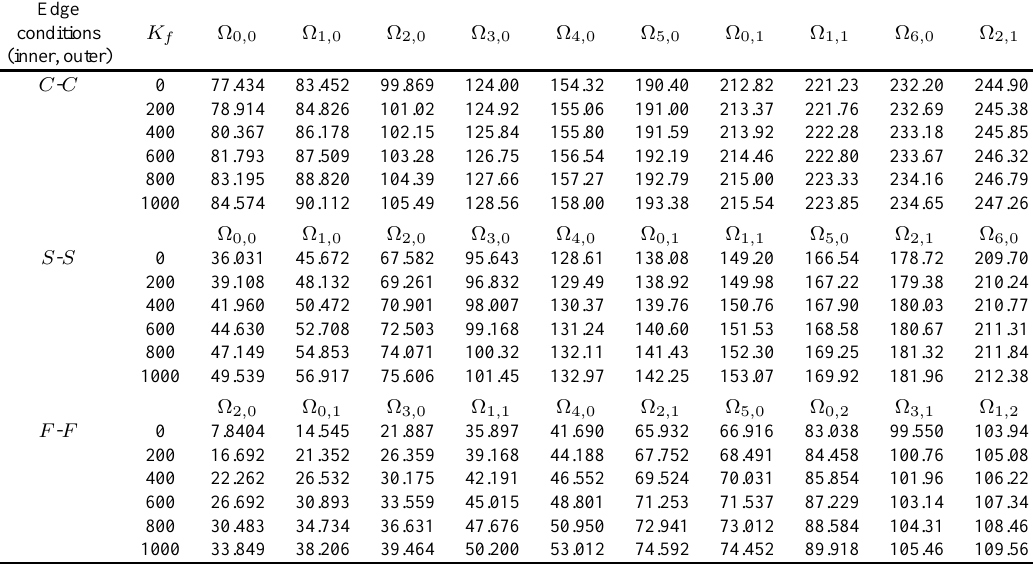
Table 7 Variation in Ω m,n with K f for C - C , S - S and F - F plates when α = β = 0 . 4 ,e r = g r = 5 . 0 ,R 0 = 0 .